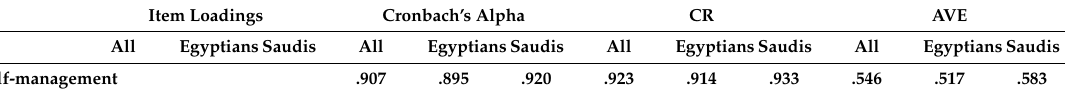
Table 2. Assessment results of the measurement